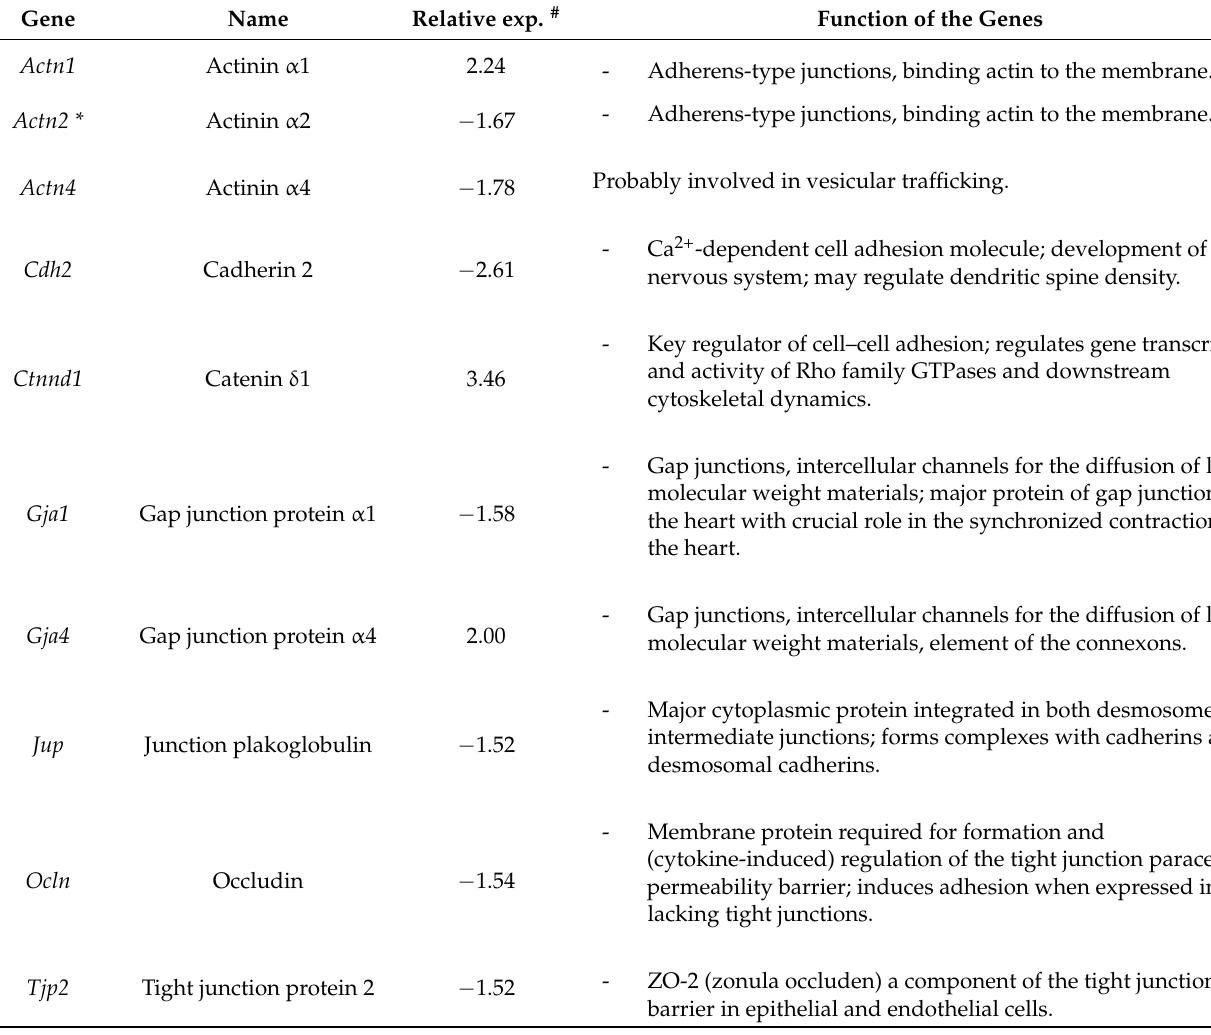
Table 1. Relative expression and functions of genes modulated by 2